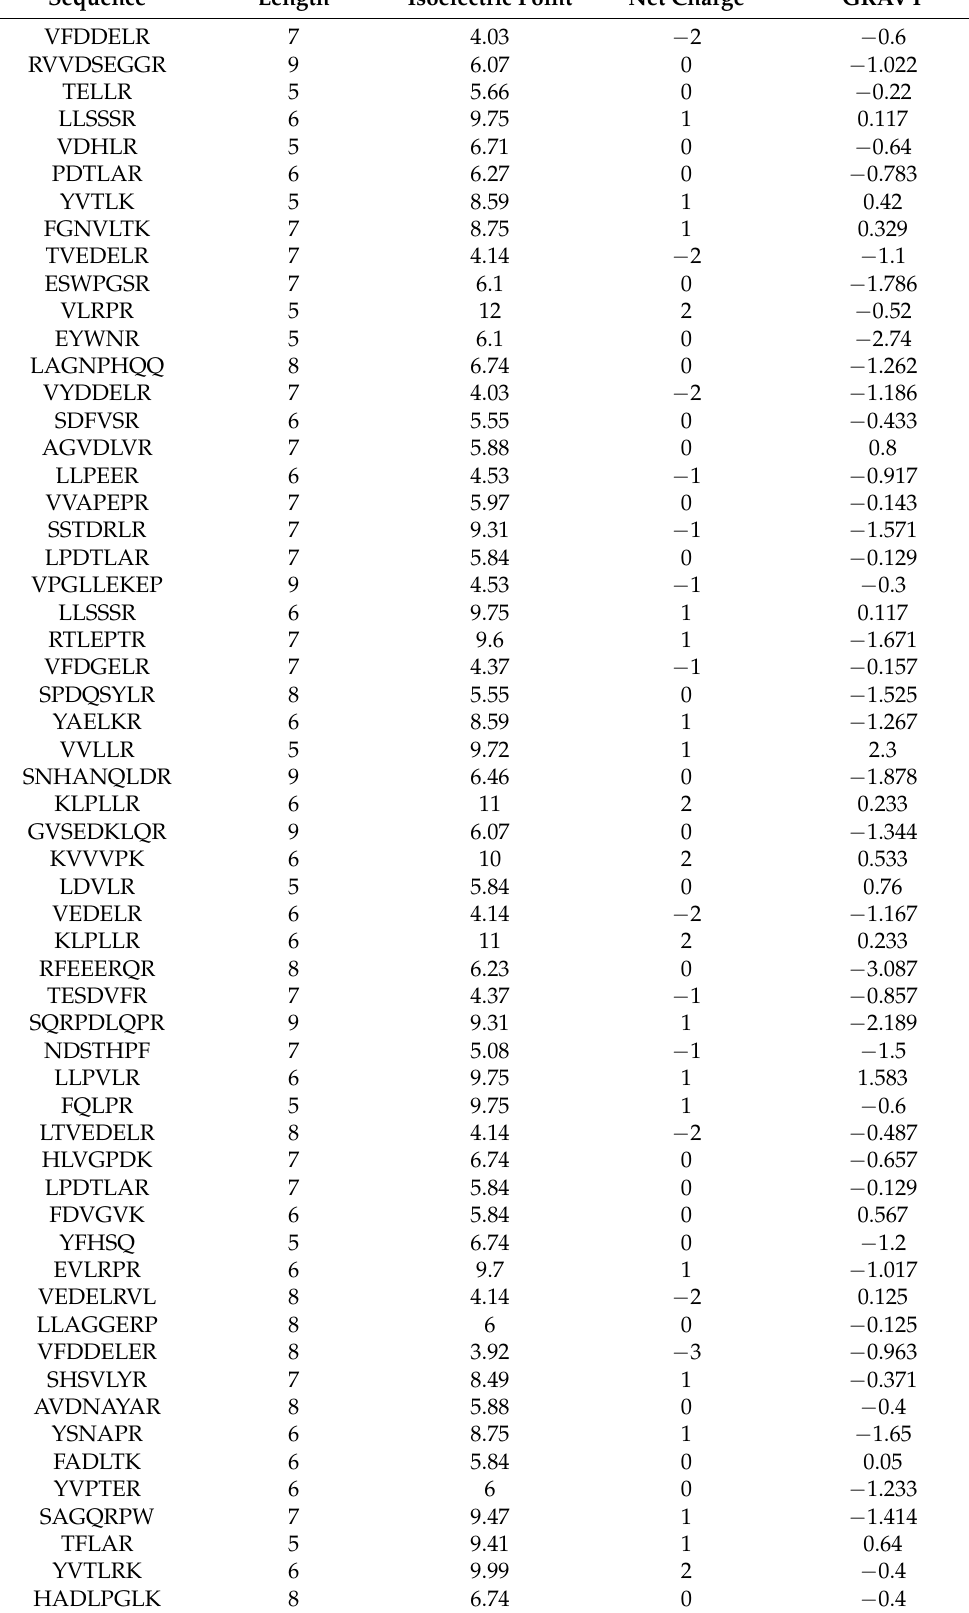
Table 1. Bioinformatic analysis of the identified peptides from the F4 fraction (MW < 1 kDa).